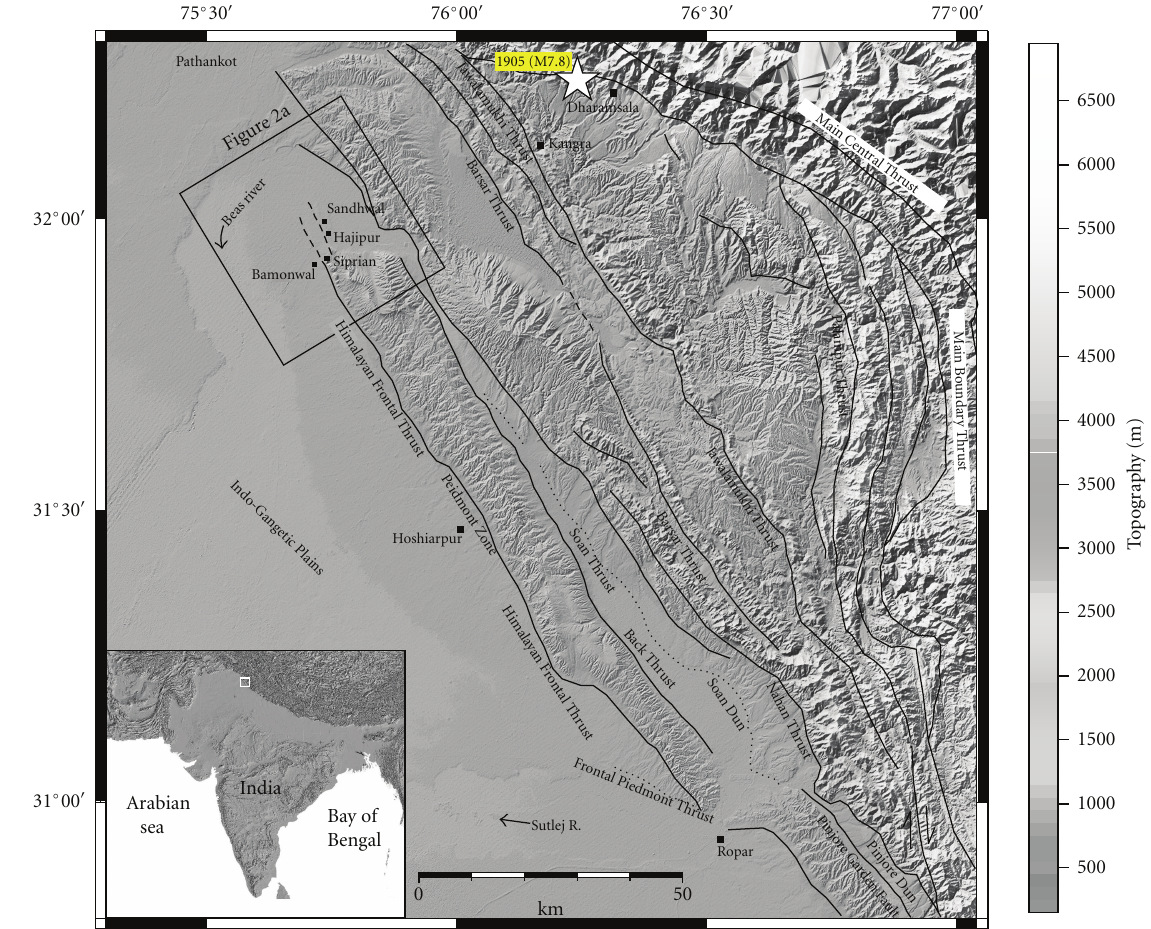
Figure 1: SRTM data of study area illustrating major faults marked by continuous lines and major geomorphic divisions around north west Himalaya. Box on top left marks the area of study which was shown in Figure 2. Inset shows DEM of India with location of study